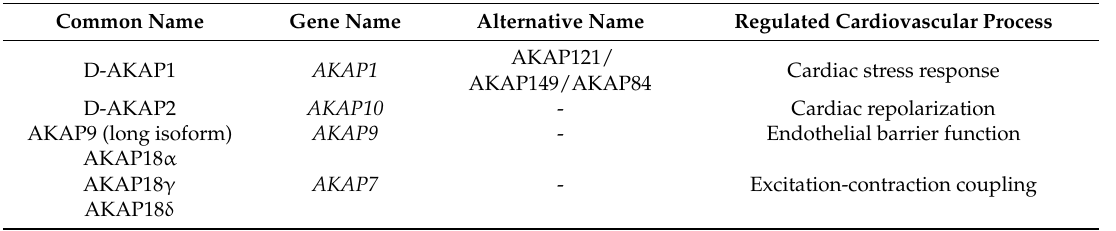
Table 1. Overview of AKAPs expressed in the heart and vasculature and of the cardiovascular processes that they